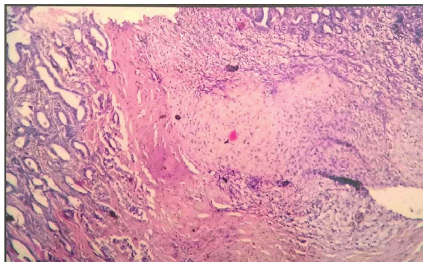
Figure 9: Solid carcinoma of the mammary gland in a 9-year-old Doberman female (H&E,